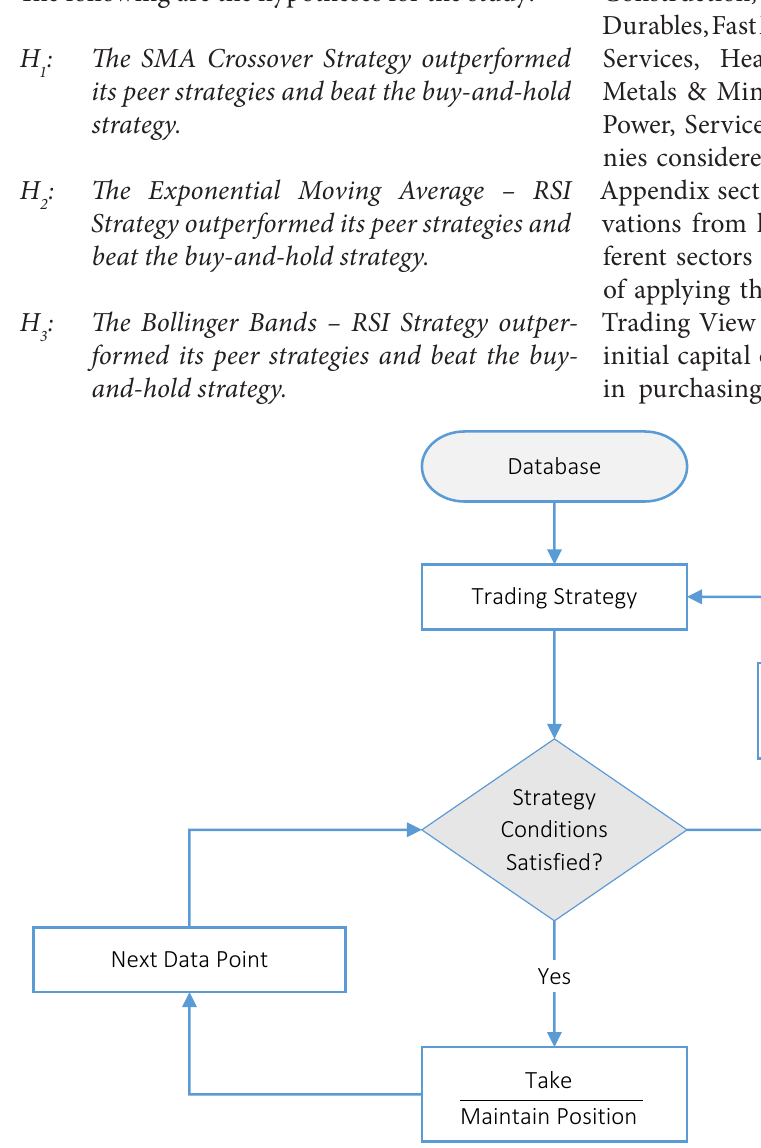
Figure 1. Flowchart depicting the framework for implementing a trading